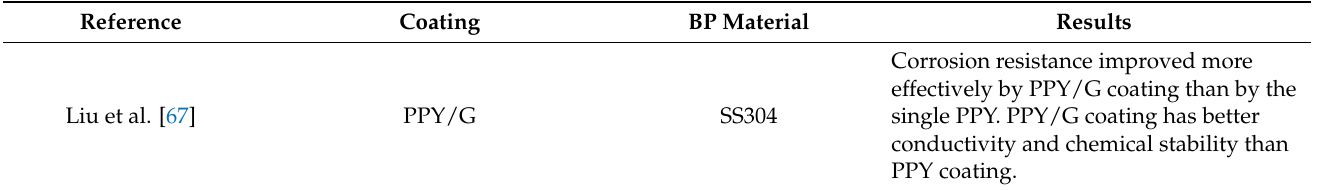
Table 4. The latest research articles about various coatings of metallic